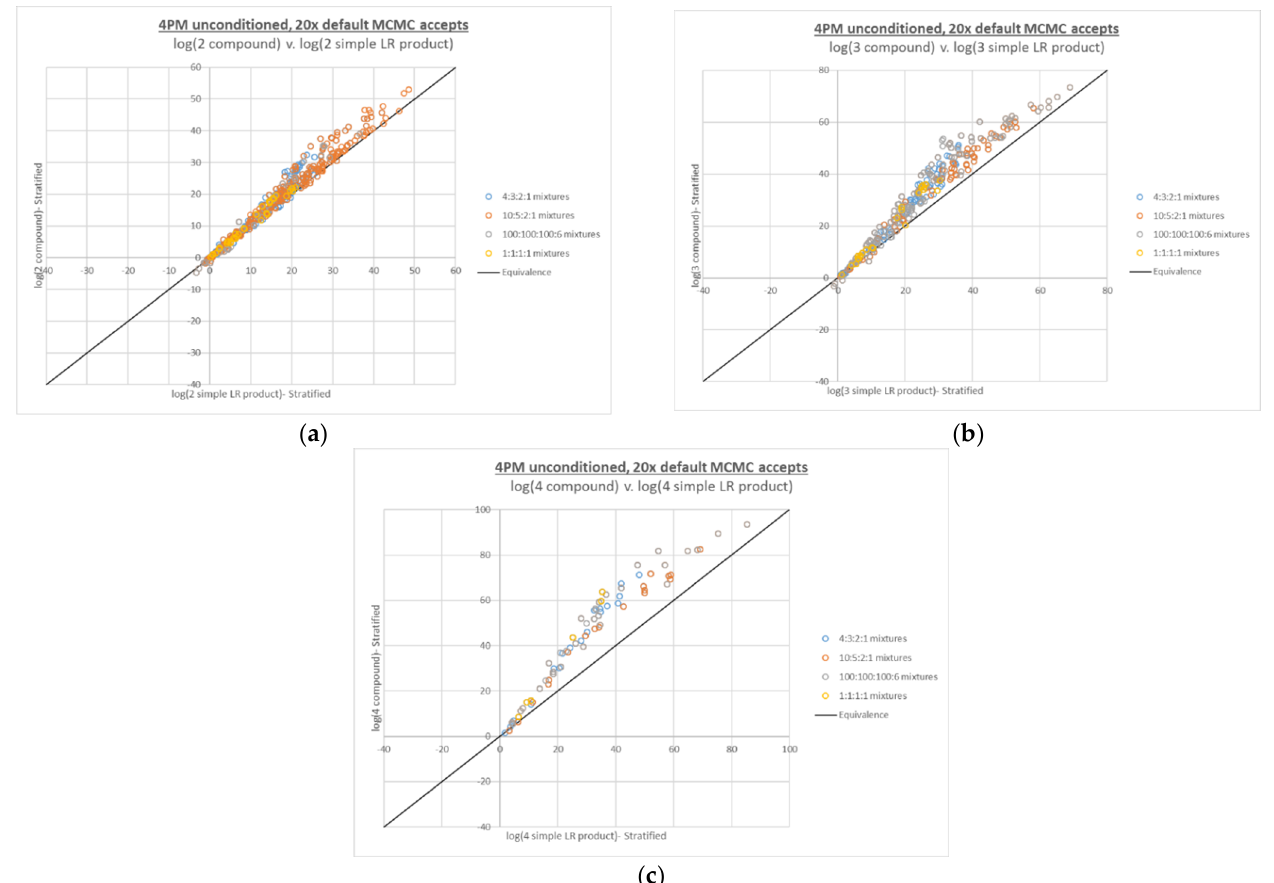
Figure 4. Four-person compound LR plots from Figure 3, recalculated based on interpretations run at 20x MCMC accepts, with: ( a ) 2 true contributors, ( b ) 3 true contributors, and ( c ) 4 true contributors in the numerator